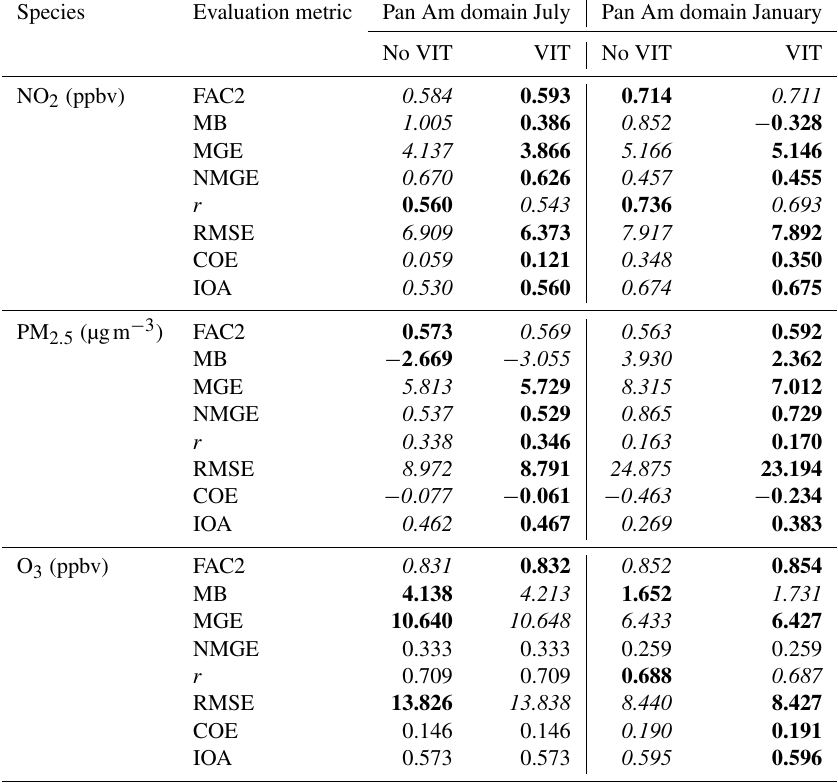
Table 3. Model performance for NO 2 , PM 2 . 5 , and O 3 in the 2.5km grid cell size Pan Am domain. No VIT refers to simulations without vehicle-induced turbulence, and VIT refers to the simulation incorporating vehicle-induced turbulence. Bold-face print identifies the better score, italics the worse score, and regular font indicates similar performance between the two simulations for each metric and chemical species